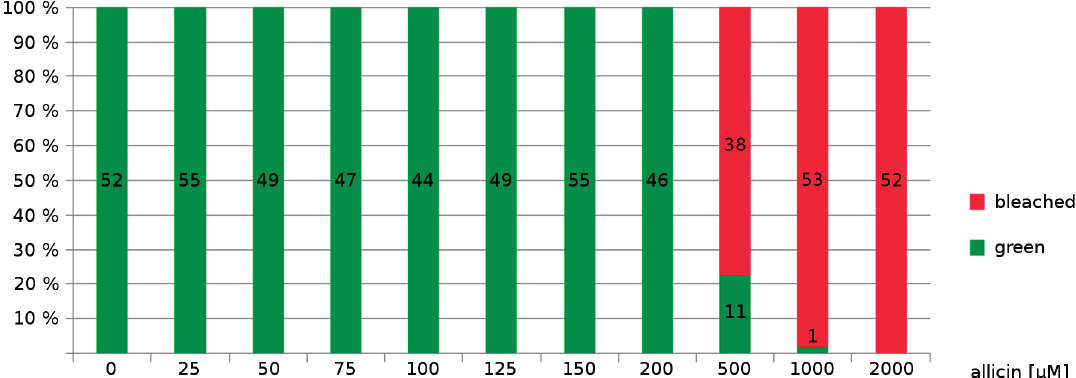
Figure 5. Allicin causes bleaching of seedlings: Sterile filter papers were placed on Murashige & Skoog (MS) medium and were sown with Col-0 A. thaliana wild type seeds. Following stratification (4 °C, 48 h), seeds were allowed to germinate and grow for three days. For allicin treatment, the filter papers were transferred onto MS medium containing different amounts of allicin. Effects on the seedlings were recorded 48 h after allicin treatment. Bleached seedlings showed either partial or complete bleaching, whereas green seedlings showed no signs of